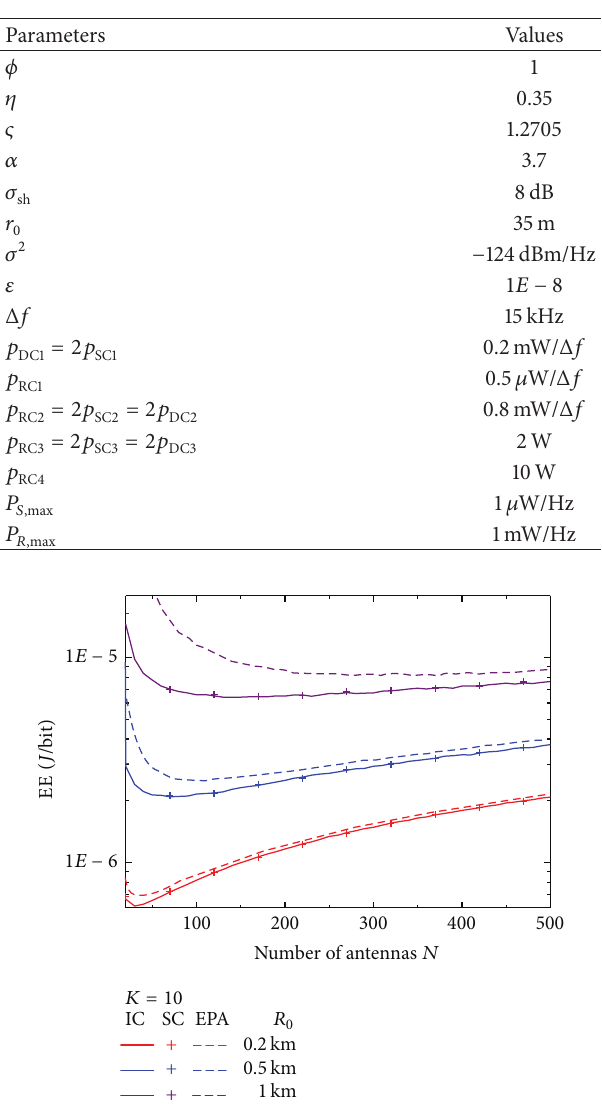
Table 1: Simulation parameters for the relay system.